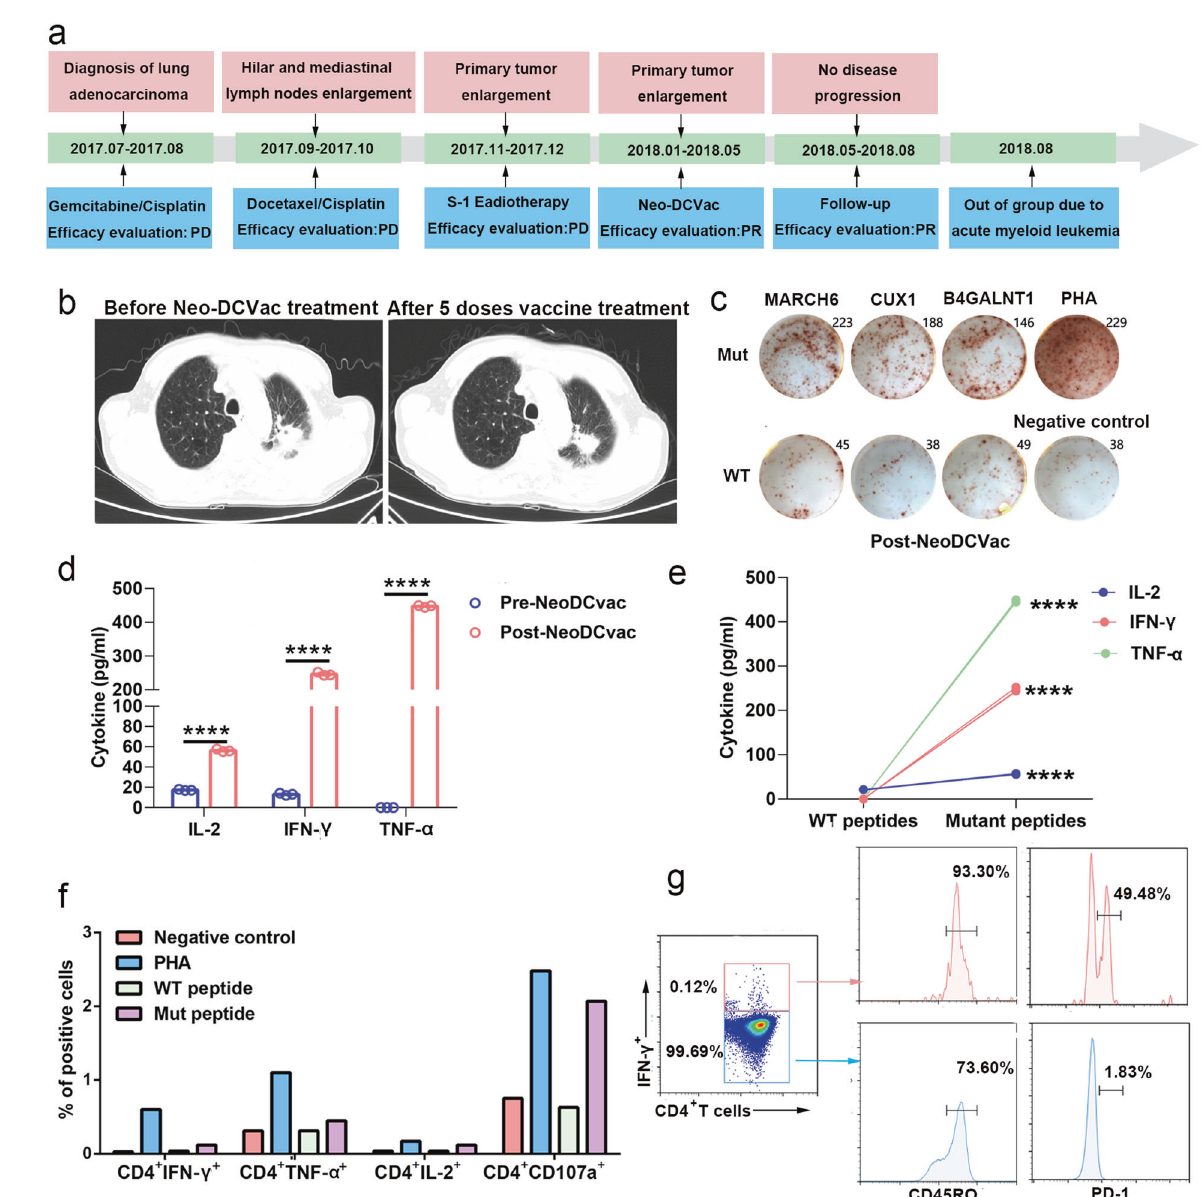
Fig. 3 Clinical and immune responses to personalized Neo-DCVac in patient 1 with metastatic lung adenocarcinoma. a Clinical course of the disease and previous treatments of patient 1. The patient failed three lines of chemotherapy and radiotherapy but remained without any signs of disease progression for 7.6 months following Neo-DCVac administration. b Computed tomography (CT) scans were performed before and after fi ve doses of personalized Neo-DCVac immunotherapy, and representative images are shown. c Autologous PBMCs were stimulated with 13 candidate mutant peptides for 10 days, after which IFN- γ ELISpot assays were performed to assess the T-cell-speci fi c antigen response. One percent phytohemagglutinin (PHA) and no peptide stimulation represent the positive and negative controls, respectively. The IFN- γ ELISpot picture of fold changes of mutant peptides/WT peptides >2 is shown. d Before and after Neo-DCVac treatment, the PBMCs were stimulated with neoantigen peptides overnight, and the concentrations of IL-2, IFN- γ , and TNF- α in the culture supernatants were measured by cytometric bead array (CBA). Data are representative of results from three independent experiments ( n = 3). This data are shown as the mean ± s.e.m. e After Neo-DCVac treatment, the concentrations of IL-2, IFN- γ , and TNF- α in the culture supernatant were measured by CBA. The data represent the results of three independent experiments. f Analysis of ex vivo T-cell responses to neoantigen peptides after overnight exposure to neoepitopes and corresponding WT peptides using intracellular cytokine staining followed by fl ow cytometry. g Ex vivo intracellular cytokine staining of PBMCs after neoepitope stimulation. PBMCs were pre-gated on CD3 + and CD4 + T cells. Cytokine-producing neoantigen- reactive cells express CD45RO and PD-1, demonstrating an antigen-experienced memory T-cell phenotype (**** P <